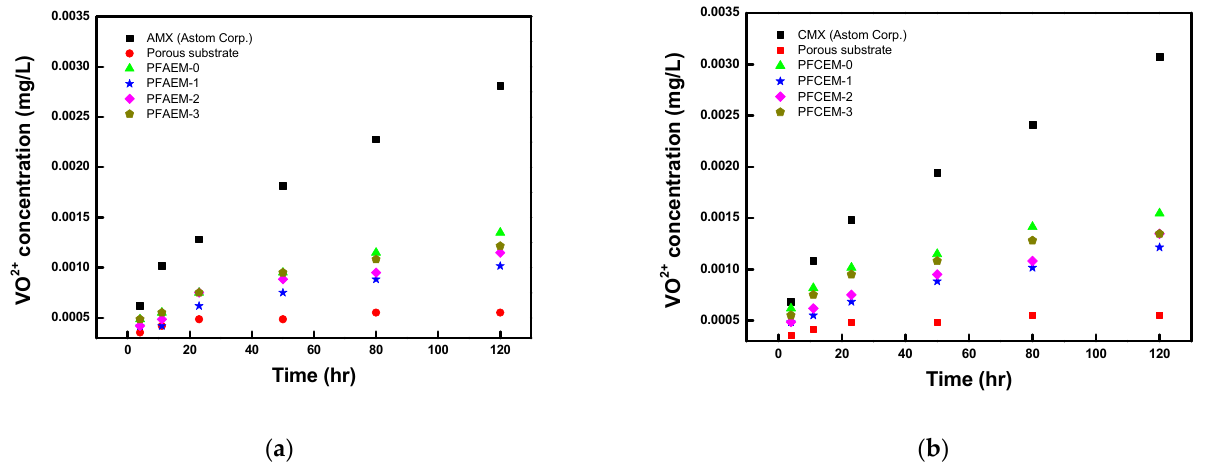
Figure 10. Time course changes in VO 2+ concentration during the chemical stability test of ( a ) AEMs and ( b ) CEMs in 0.1 M V 2 SO 5 (in 5 M H 2 SO 4 ).